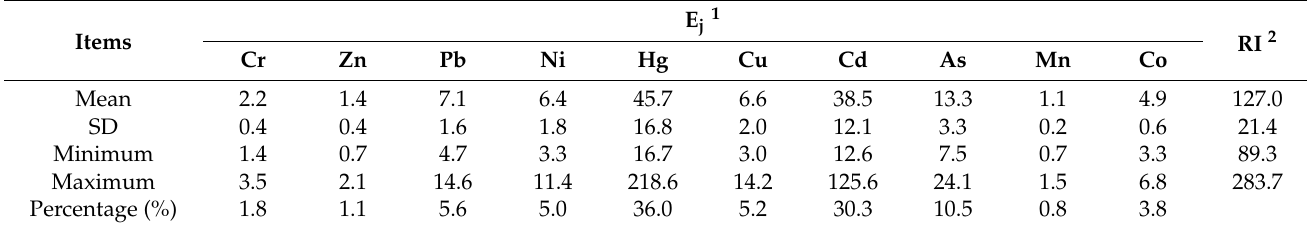
Table 5. Results of potential ecological risk assessment HMs in the soil